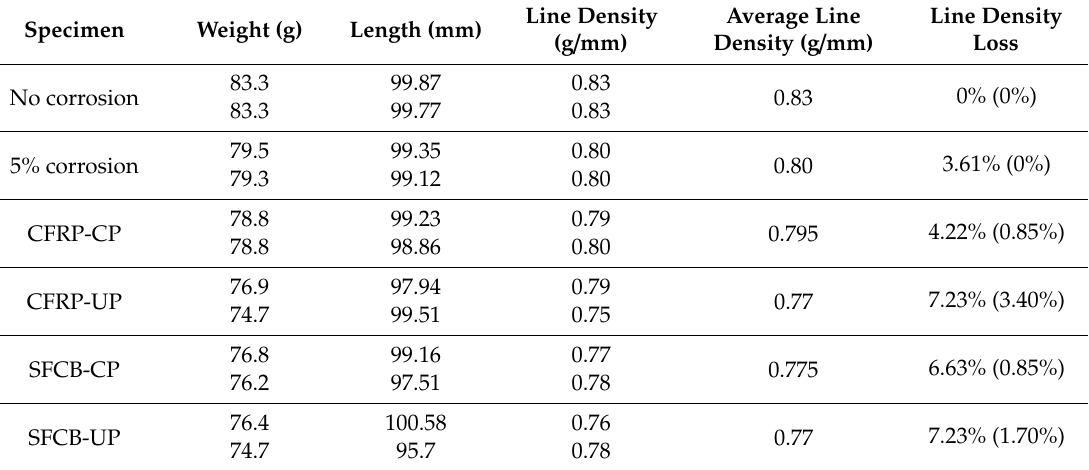
Table 6. Characterization of corrosion rate for steel